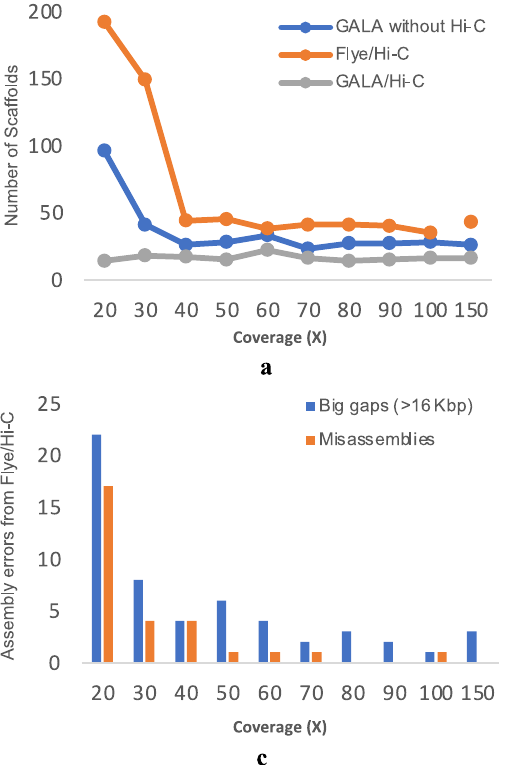
mis-assembly has been identi fi ed in the assembly by GALA without Hi-C data with 30× coverage of sequencing data. In ( d ), the number of scaffolding groups obtained by GALA changes signi fi cantly with the number and the quality of pre- liminary assemblies used in the Oryza sativa circum-basmati landrace Dom Su fi d genome assembly with the Nanopore sequencing data. Here n =35, 35, 21, 7 and 1 for the exhaustive strategy, and n =15, 20, 15, 6, and 1 for the selective strategy, respectively.Themedian(line),1stand3rdquartiles(boundsofthebox),minimum and maximum (whiskers) are shown in the box